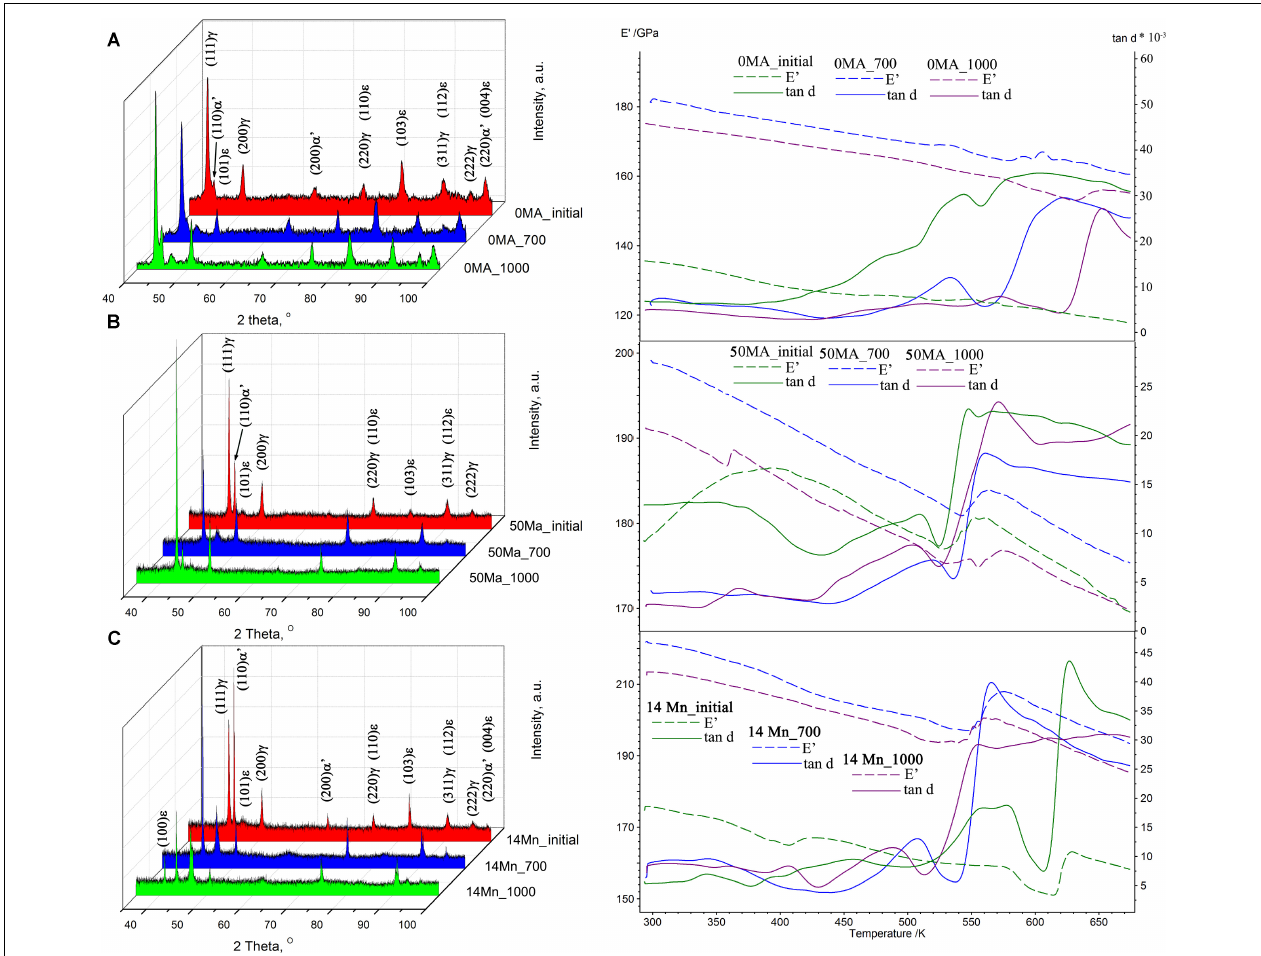
FIGURE 6 | Solution treatment effects on the structure and dynamic behavior of: (A) P/M specimens sintered from pressed as blended powders (0_MA), (B) 50% as blended powders substituted with MA’ed powders (50_MA) and (C) ingot metallurgy specimens (14 Mn) (adapted after Pricop et al., 2015a, © owned by the